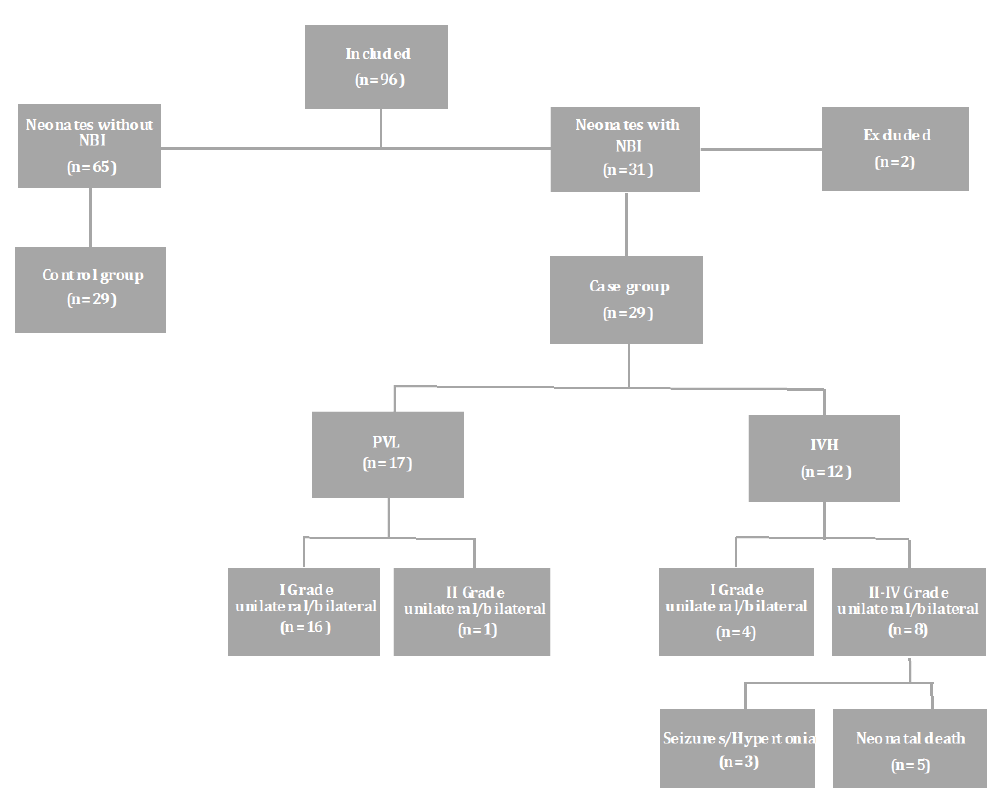
Figure 1. Flowchart of the studied population and perinatal outcome. NBI: neonatal brain injury; IVH: intraventricular haemorrhage; PVL: periventricular leukomalacia. Reprinted from Clinica Chimica Acta, 510, Metallinou D, Karampas G, Nyktari G, Iacovidou N, Lykeridou K, Rizos D, S100B as a biomarker of brain injury in premature neonates. A prospective case—control longitudinal study, 781–786, Copyright (2020), with permission from Elsevier. Table 1. Maternal demographic and clinical characteristics of control and cases neonates [22].